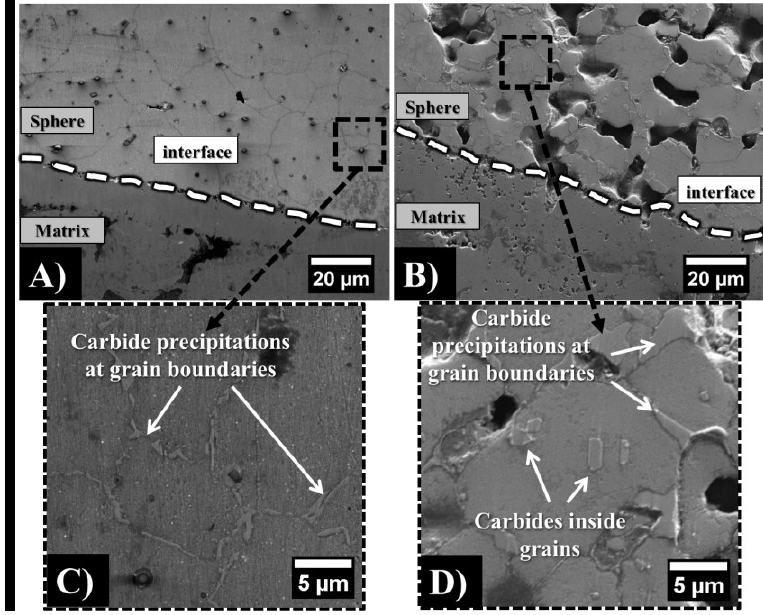
Figure 6. Secondary-electron SEM images of etched samples at higher magnification for Al-S CMF made with ( A ) 3.7 mm sphere; ( B ) 4.0 mm sphere, and detail of sphere wall microstructure for ( C ) 3.7 mm and ( D ) 4.0 mm